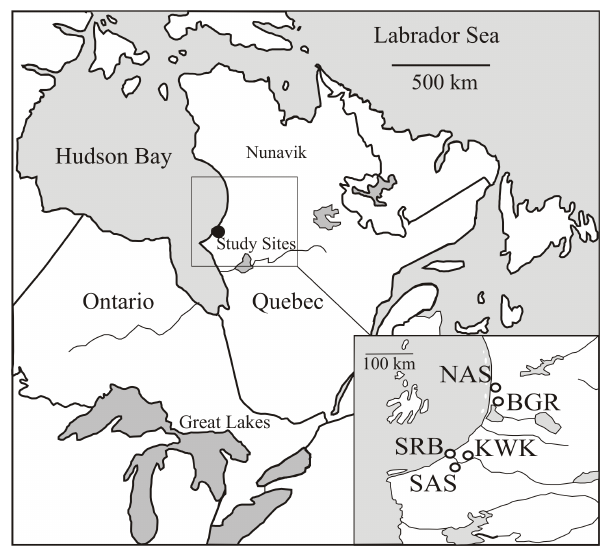
Figure 1. Location of the study area in subarctic